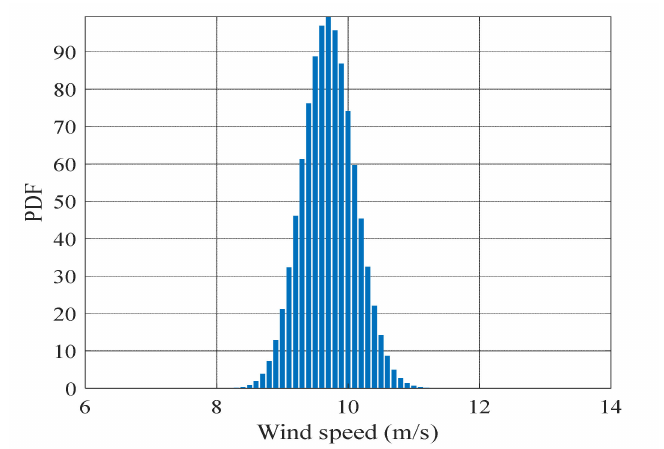
Figure 13. PDF of wind speed at hour